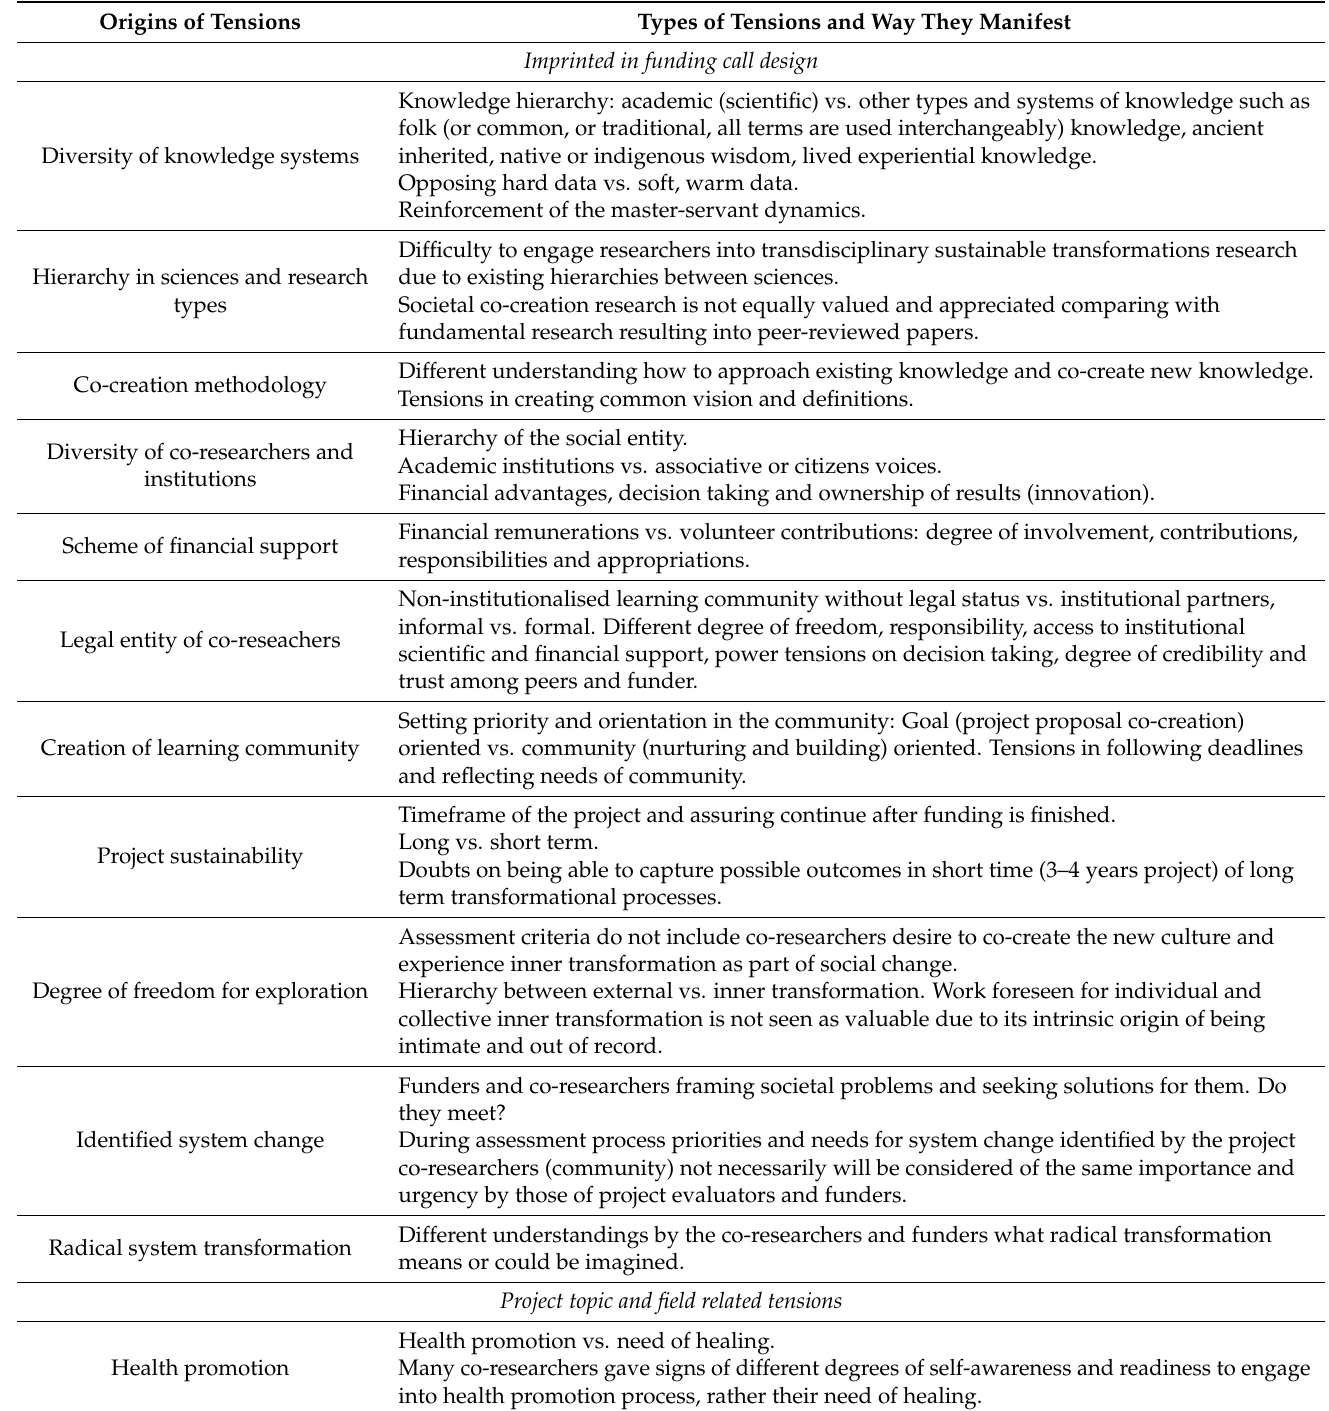
Table A1. Original thoughts of tensions identified during co-creation by the first and second authors (collaborative autoethnographic results), mostly compiled in late 2019, early